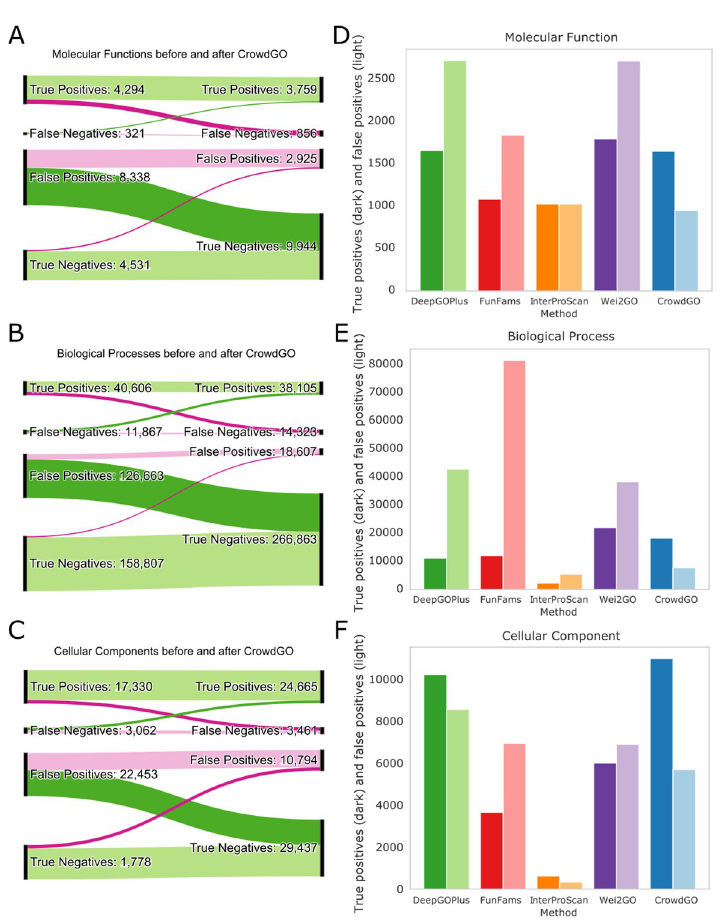
Fig 2. Impact of CrowdGO annotation re-evaluations on calling true and false positives and negatives. Sankey plots show the numbers of true or false positive or negative gene-term annotations before (left) and after (right) re- evaluation by CrowdGO (using the CrowdGOFull model) for the three gene ontologies, (A) Molecular Function, (B) Biological Process, and (C) Cellular Component, for the V162-V198 testing dataset. Correct re-evaluations are shown in dark green (false positives to true negatives and false negatives to true positives), and incorrect re-evaluations are shown in dark pink (true positives to false negatives and true negatives to false positives). For unchanged annotations, correct affirmations are shown in light green (true positives and true negatives), and incorrect affirmations are shown in light pink (false positives and false negatives). Bar plots show for each method and CrowdGO (coloured as in Fig 1) counts of true positives (dark colours) and false positives (light colours) for the three gene ontologies, (D) Molecular Function, (E) Biological Process, and (F) Cellular Component, for the V162-V198 testing dataset.